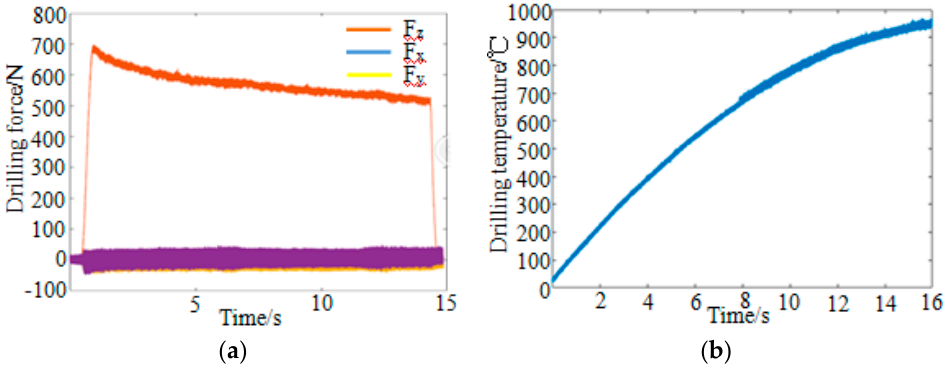
Figure 4. Variation of drilling force and drilling temperature. ( a ) Drilling force; and ( b ) drilling temperature.